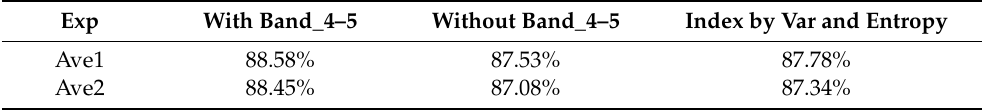
Table 7. Test results of LSTM.